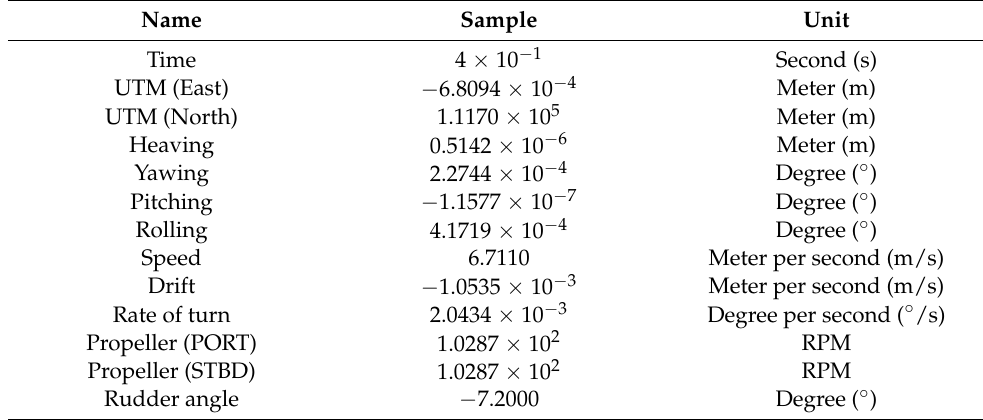
Table 2. Elements of raw data.